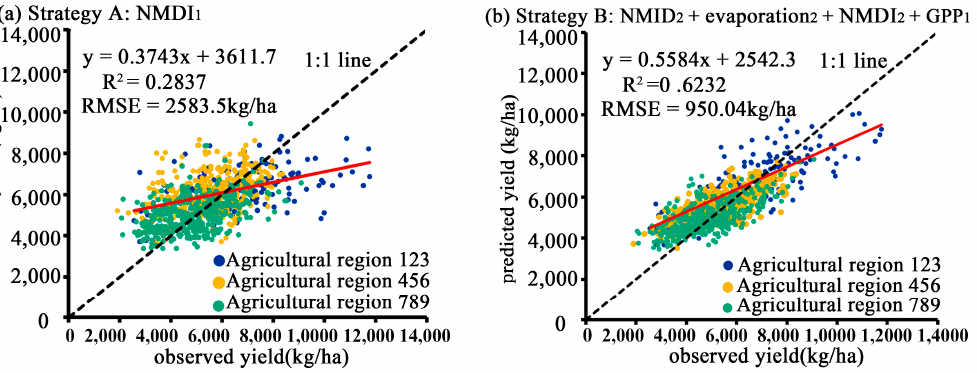
Figure 8. ( a ) Maize yield estimation accuracy of strategy A, ( b ) Maize yield estimation accuracy of strategy B.